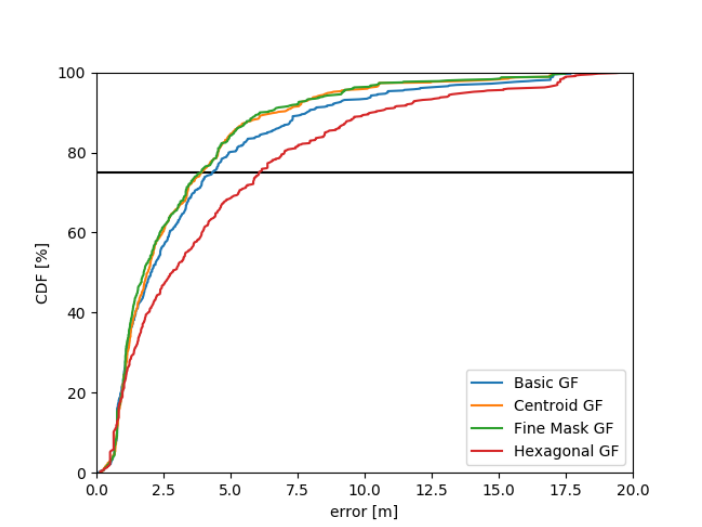
Figure 8. Comparison of lgrid-based filters on all checkpoints in the first experiment scenario with different configurations.